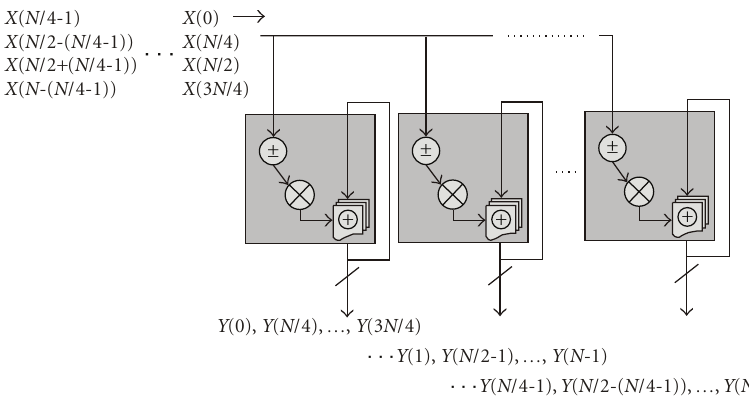
Figure 3: DFT Processor: Serial in-Parallel out configuration.